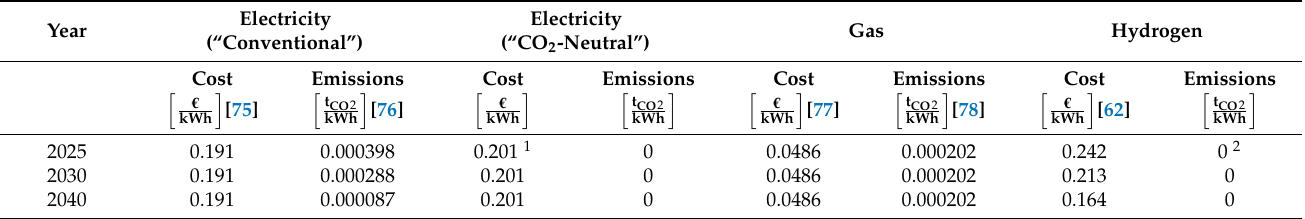
Table 2. Energy carrier cost